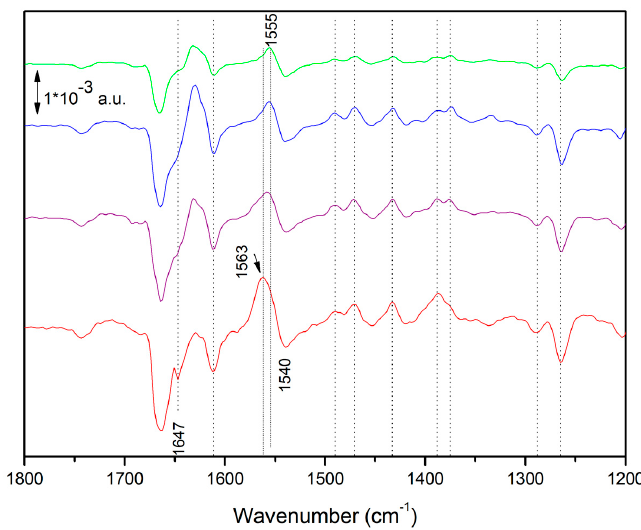
Figure 2. Fourier Transform Infrared (FTIR) difference spectra on Rhoodobacter (Rb.) sphaeroides chro- matophores recorded under illumination with different intensities, between 2 and 4 s after the onset of light exposure. The relative light intensity is (top to bottom) 1 (green):2 (blue):5 (purple):8 (red). Spectra are recorded on the same sample; measurement times (both in terms of light exposure and number of measurement cycles) are minimized in order to have negligeable light-induced sample degradation or fatigue. Experiments repeated on other samples provided similar results. Peak position should be considered to have a ± 1 cm − 1 uncertainty.